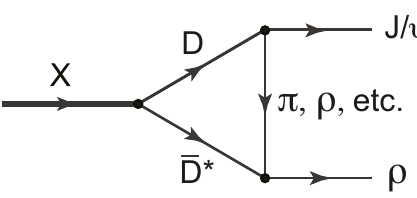
Figure 3 . Decay mechanism of X to the J= (cid:26) channel in an approach in which X is obtained from the D (cid:22) D (cid:3) interaction [47].